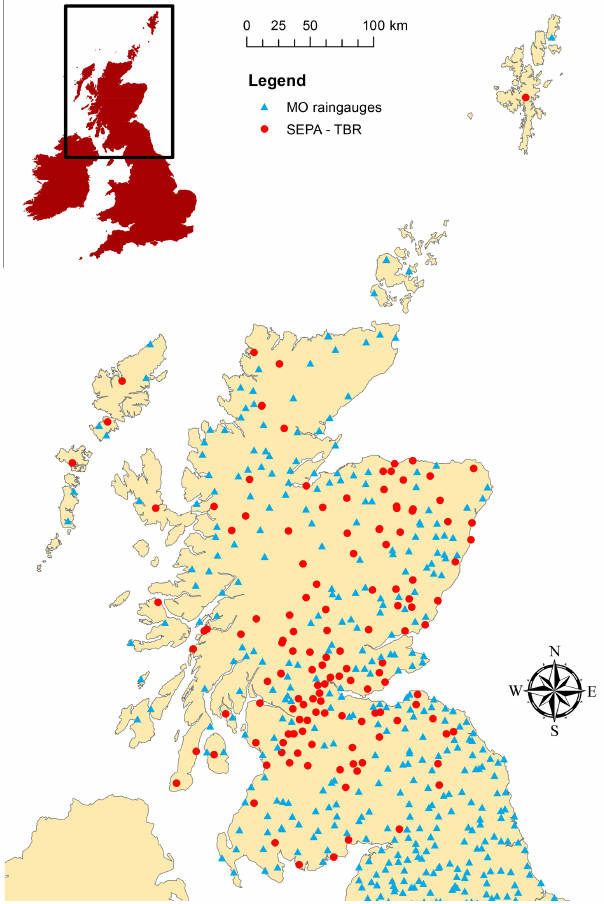
Figure 8. Map of SEPA tipping bucket rain gauges (TBR) used for validation purposes (red circles) and Met Office (MO) rain gauges network (blue triangles). The MO rain gauges are represented on the map only if they have data available for at least 50% of the days between 2007–2010 (validation